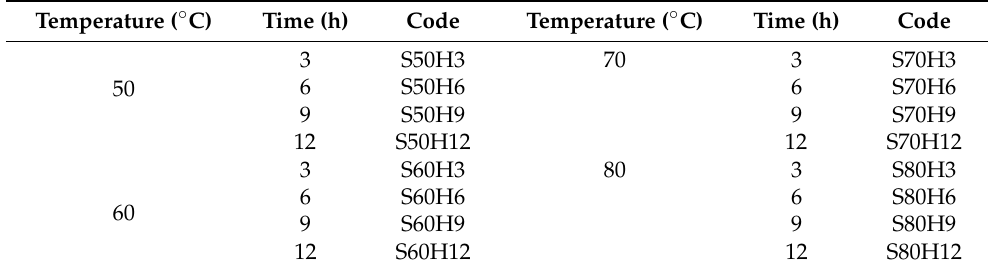
Table 1. Notation samples in this study with the variation of first crystallization time and temperature. Temperature ( ◦